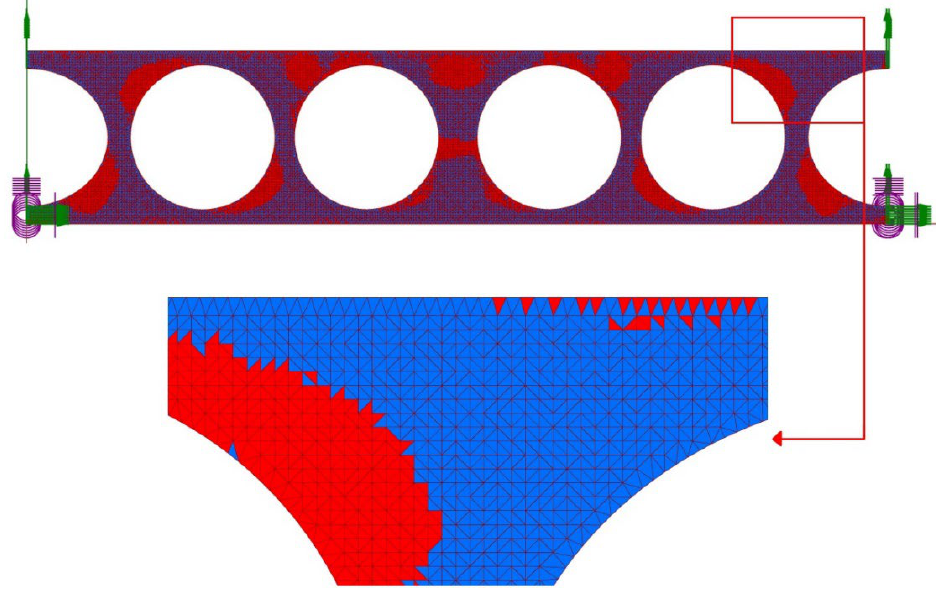
Figure 16. Sig1-Val and Sig2-Val path.